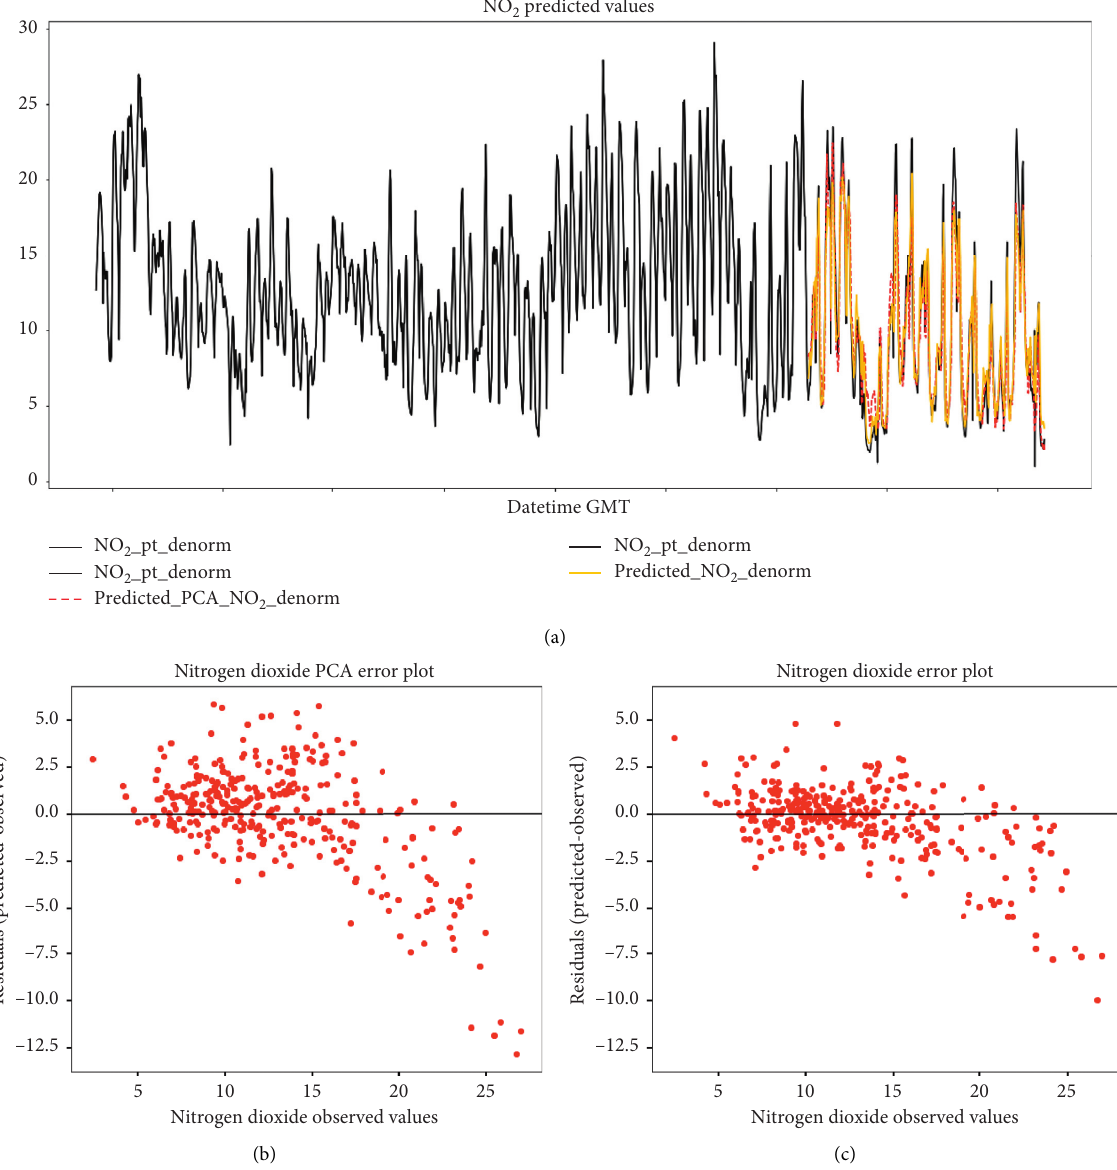
Figure 13: (a) Nitrogen dioxide observed values (black line) and obtained forecasts with PCA-SVR model (red line) and SVR-RBF model (yellow line). (b, c) Two scatter plots with model’s respective errors plotted against observed NO 2 values for the same